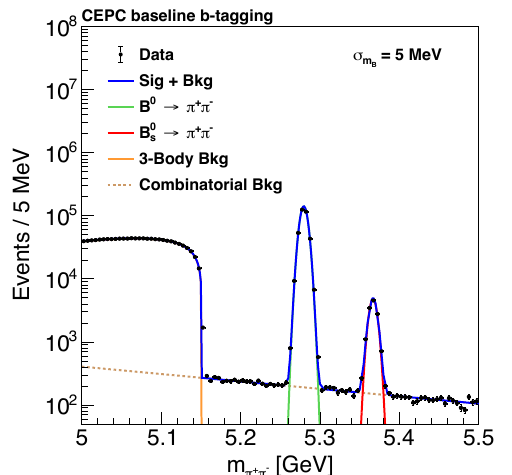
distribution in the branching ratio measurement of B 0 → π + π − π + π −